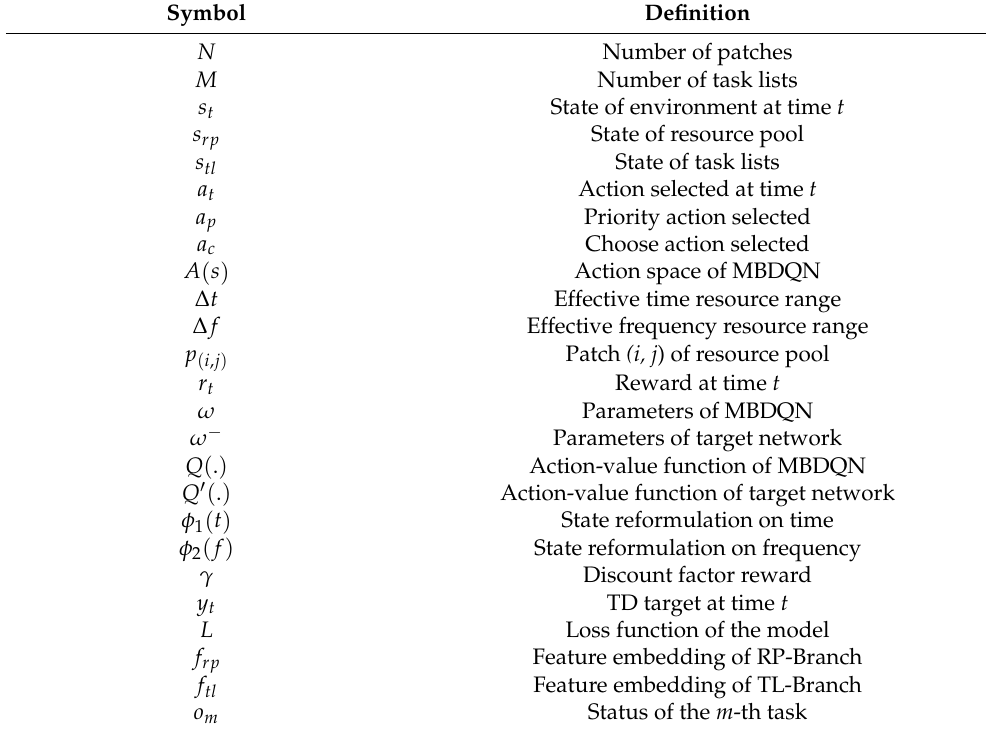
Table 1. Notation